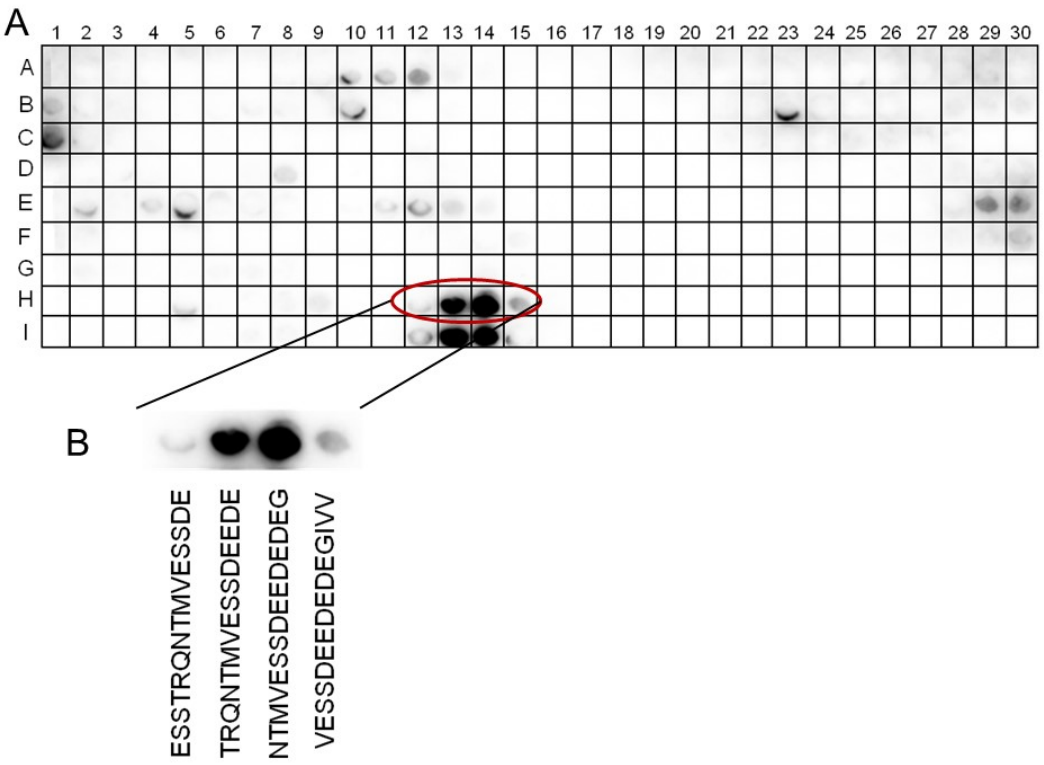
Figure 3. Peptide-spot binding assay with At SOS1 C-terminus. Fifteen amino acid long peptides were spotted on a cellulose membrane and incubated with recombinant (10xHis)-labelled At 14-3-3 ω ( A ). The spots correspond to the respective region of At SOS1 C-terminus as indicated. ( B ) Anti-poly-Histidine-antibody in combination with an HRP-coupled anti-mouse antibody, ECL™ and luminescence imaging were employed using an Odyssey ® Fc Imaging System (LI-COR Biosciences, Lincoln, Nebraska, USA).